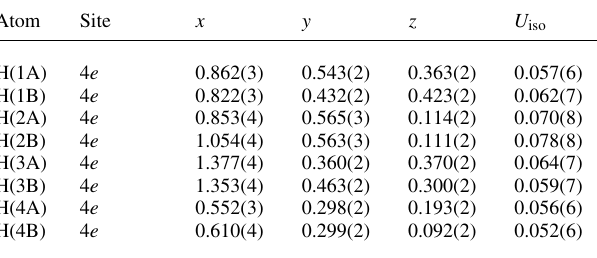
Table 2. Atomic coordinates and displacement parameters (in Å 2 )